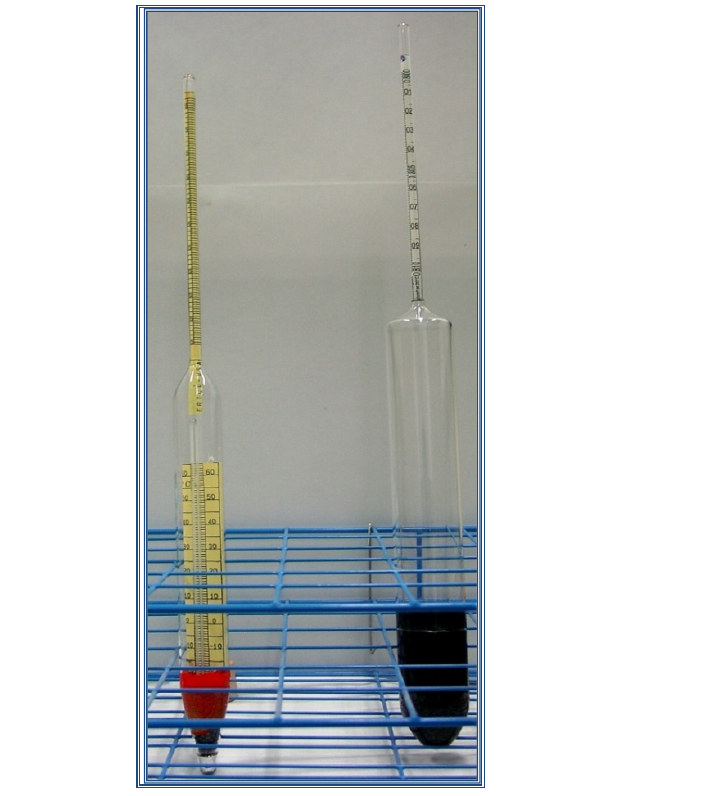
Figure 8. Hydrometers used in the